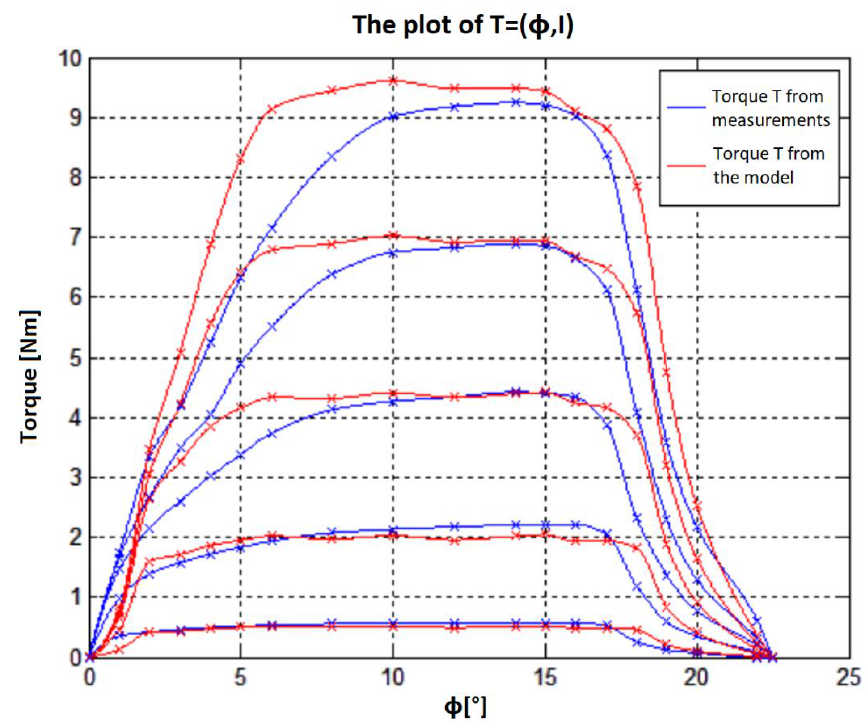
Figure 24. The 10/8 motor: juxtaposition of the torque characteristics between those from the model and those from laboratory measurements.